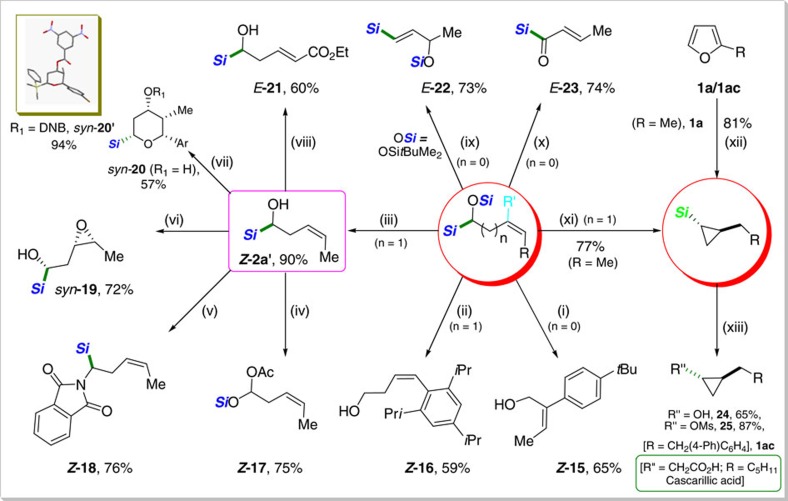
Enrichment and elaboration of products.(i) CsF (5 equiv.), 23 °C, 8 h, DMF, (R′=(tBu)-C6H4, R=Me). (ii) TBAF (3 equiv., 1 M in THF), 23 °C, 15 h, (R′=H, R=(2,4,6-triisopropyl)C6H2). (iii) K2CO3 (2 equiv.), MeOH, 0→23 °C, 4 h, (R′=H, R=Me). (iv) Pb(OAc)4 (1.1 equiv.), C6H6, 0→23 °C, 2 h. (v) PPh3 (1.3 equiv.), Diethyl azodicarboxylate (1.3 equiv.), Phthalimide (1.3 equiv.), THF, 0→23 °C, 20 h. (vi) VO(acac)2 (5 mol%), TBHP (2.2 equiv.), CH2Cl2, −10→0 °C, 5 h. (vii) p-Br-C6H4CHO (1.2 equiv.), TFA (2.5 equiv.), CH2Cl2 (3 ml), −20 °C, 3 h; DNB=3,5-dinitrobenzoyl. (viii) Ethyl acrylate (10 equiv.), Grubbs-II (5 mol%), 50 °C, 15 h. (ix) BF3·Et2O (1.1 equiv.), CH2Cl2 (0.14 M), −78 °C, 5 h, (R′=H, R=Me). (x) (COCl)2 (2.0 equiv.), DMSO (4.0 equiv.), Et3N (5.0 equiv.), −78 °C, 4 h, (R′=H, R=Me). (xi) B(C6F5)3 (3.0 mol%), PhMe2SiH (1.5 equiv.), CH2Cl2, 0→23 °C, 12 h, (R′=H, R=Me). (xii) 2-Methylfuran (1a, 1.0 equiv.), B(C6F5)3 (5.0 mol%), Ph2SiH2 (3.0 equiv.), CH2Cl2, 0→23 °C, 8 h. (xiii) (a) 1ac (1.0 equiv.), B(C6F5)3 (5.0 mol%), Ph2SiH2 (3.0 equiv.), CH2Cl2, 0→23 °C, 10 h; (b) H2O2 (20 equiv.), KF (10 equiv.), KHCO3 (10 equiv.), THF/MeOH (1/1), 23 °C, 16 h. (Si=SiMe2Ph, Si=SiPh2H/SiMe2Ph).